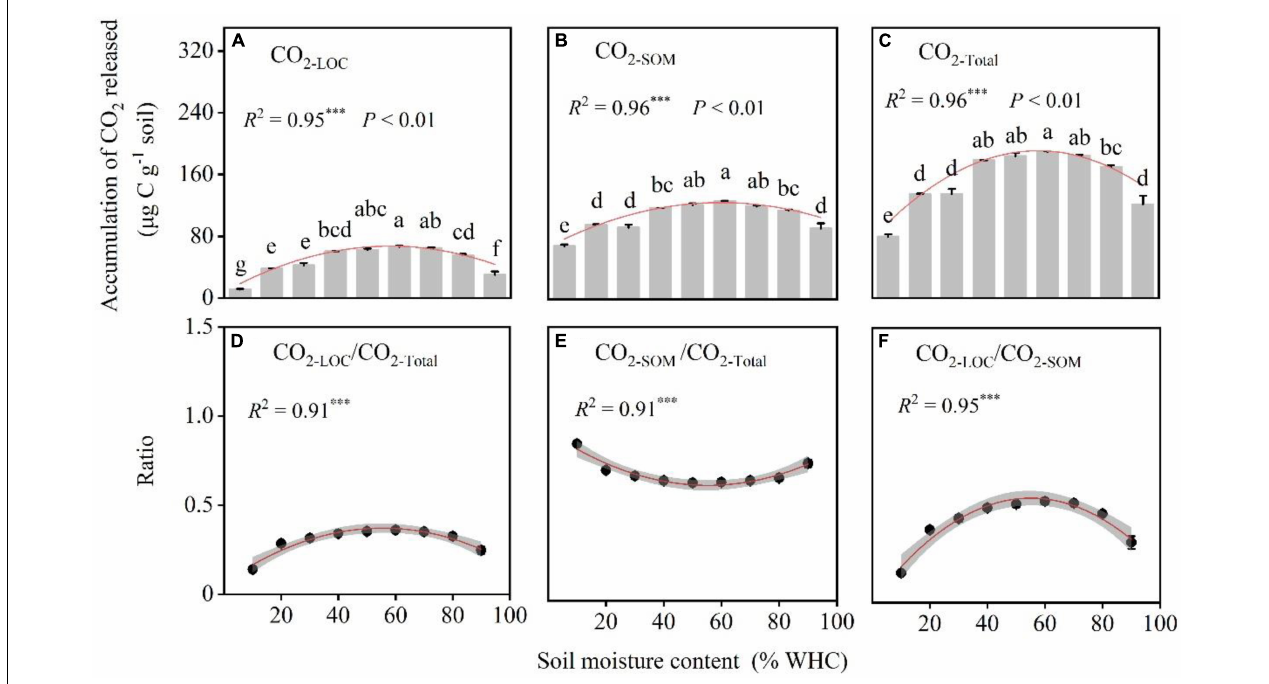
FIGURE 5 | The accumulation of CO 2 released and their ratios under different soil moisture treatments. (A–C) The cumulative CO 2 emissions from LOC (CO 2 − LOC ), soil organic matter (CO 2 − SOM ), and the total respiration rate (CO 2 − Total ). (D–F) Ratios of CO 2 accumulation from different C sources. P -values and different letters indicate significant differences among the different soil moisture content treatments ( n = 3, mean ± SE). Red lines indicate the fitted curves of the corresponding parameters vs. soil moisture content. R 2 and *** denote the goodness of fit and significance level, and the *** indicate statistical difference level of P < 0.001.